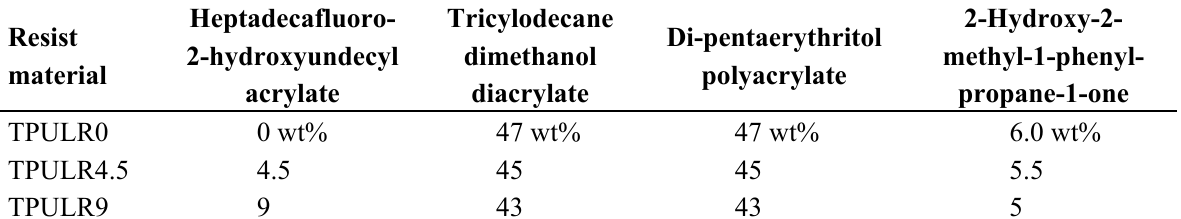
Table 1. Formulation of the developed nanoimprint resist materials TPULR9, TPULR4.5, and